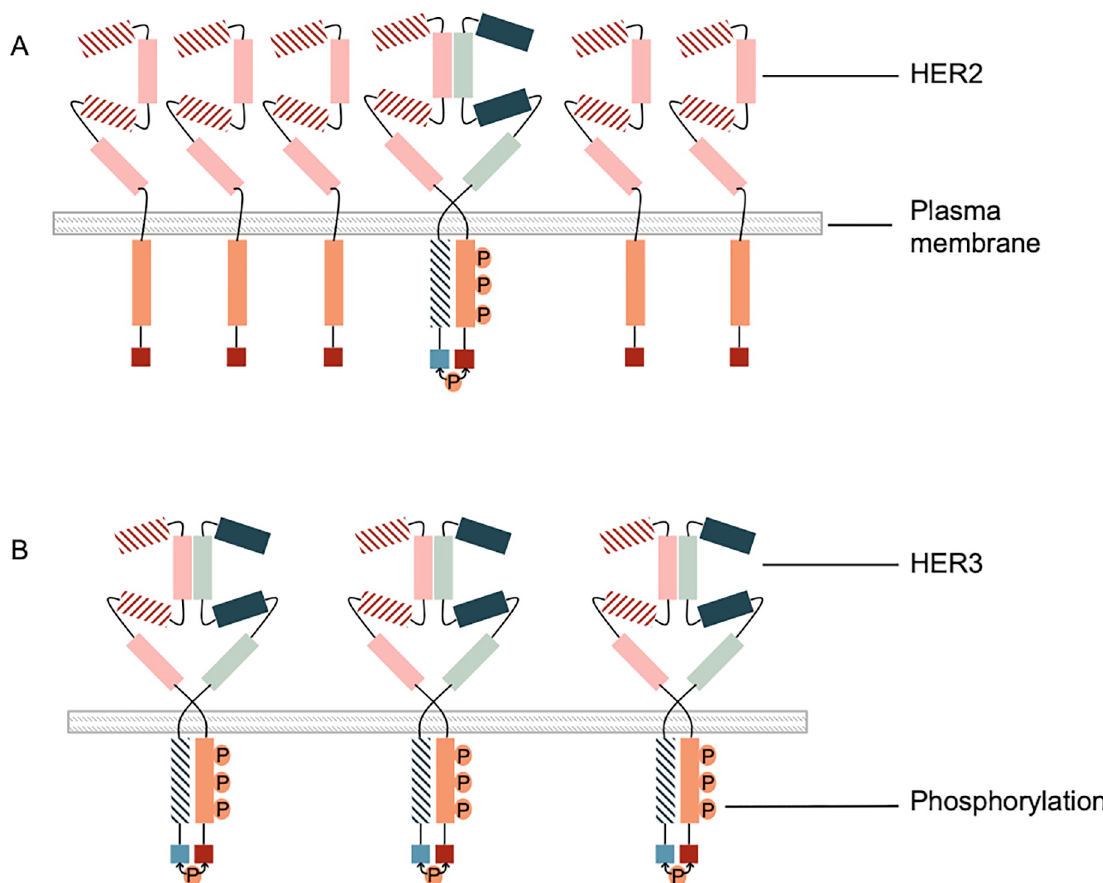
Fig 6. Overexpresion versus overphosphosrylation of HER2. A. Overexpression of HER2 with non-overphosphorylation of HER2 (HER2+; pHER2-). B. Non-overexpression of HER2 with overphosphorylation of HER2 (HER2-; pHER2+). In this study we show that BT-474 and SKBR3, which are HER2+/pHER2 Y877 + have a better response to trastuzumab than MDA-MB-453, which is also HER2+ but not phosphorylated at Y877 (HER2+/pHER2 Y877 − ). This is concordant with studies reporting that HER2 phosphorylation leads to a better response to trastuzumab in HER2-positive BC tumors [35–38].As shown in a study by Giuliani et al ., among HER2+ BC patients treated with trastuzumab, 89% with pHER2Y 1248 + showed a positive response while only 49% of pHERY 1248 − presented a positive response [39]. These results suggest that the combination of HER2+/pHER Y877 + could indeed predict a better response to trastuzumab. However, our study is the first to examine HER2 phosphorylation at position Y877 in HER2-negative BC cell lines with regard to trastuzumab treatment. We demonstrated here that the decrease in proliferation in HER2-negative BC cell lines is Y877-phosphorylation-specific, as the TNBC cell line MDA-MB-468, which is HER2 − /pHER2 Y877 +, displays sensitivity to trastuzumab. Studies have reported that Y877 phosphorylation is a marker of HER2 activation. This again is in agreement with our results showing that HER2 over-activation by over- phosphorylation at Y877 could be an additional biomarker in BC diagnosis. The BC cell lines included in this study were selected based on their HER2 and pHER2 Y877 status. However, these cell lines also have other molecular characteristics. Multiple cell cycle proteins (RB1, p53, BRCA1 and BRCA2) and survival signaling pathways (PTEN and PIK3CA) are involved in BC and can affect the response to treatment [43,44]. Only MDA-MB-468 and BT-549 (HER2 − /pHER2 Y877 +) have a loss of RB1 and PTEN compared with the other cell lines, but they are still sensitive to trastuzumab. MDA-MB-231 (HER2 − /pHER2 Y877 − ) has the same molecular characteristics for RB1, p53, PTEN, PI3KCA, BRCA1 and BRCA2 as SKBR3 and MDA-MB-453, which are both sensitive to trastuzumab (S1 Table). Hence, it seems that these proteins are not involved in the response to the trastuzumab.